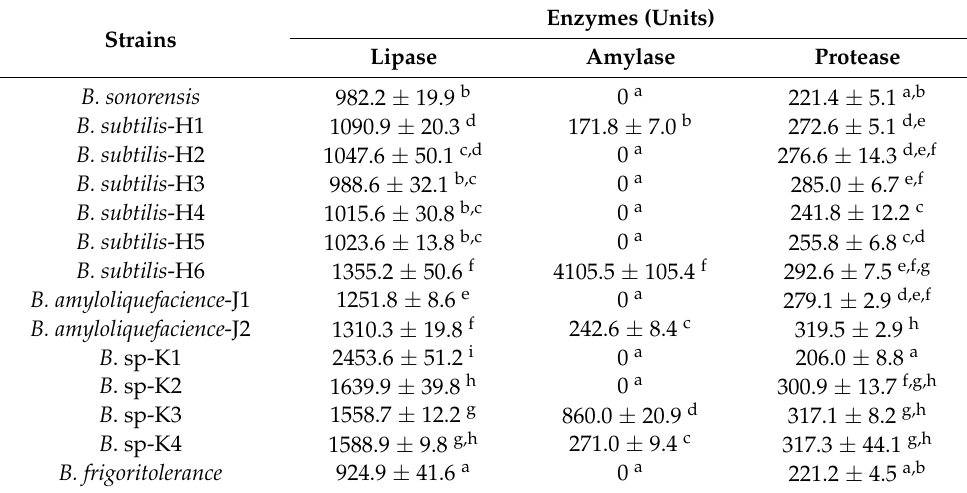
Table 1. Enzyme activities of various strains isolated from Doenjang . Enzymes (Units) Strains Lipase Amylase